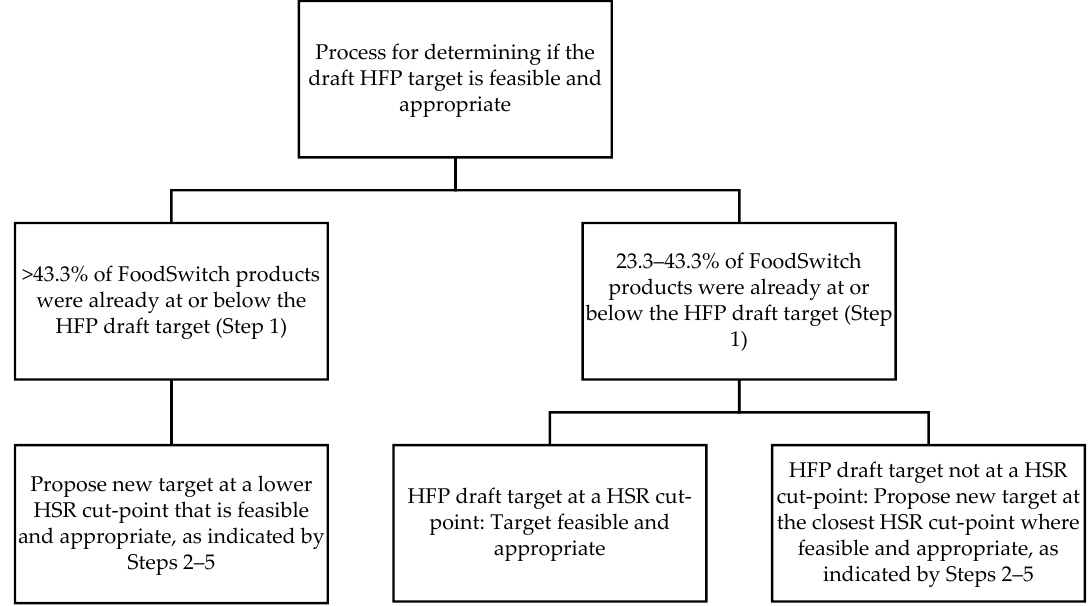
Figure 1. Process for assessing if draft Healthy Food Partnership (HFP) targets are feasible and appropriate. HSR: Health Star Rating.